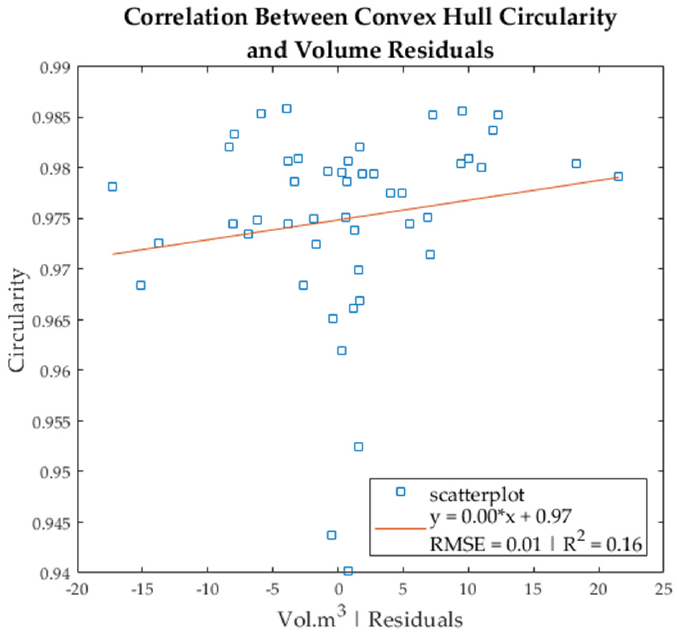
Figure 7. Correlation between the circularity (deviation of stem shape profile from regular circle) and the produced volume residuals (observed vs. convex hull).